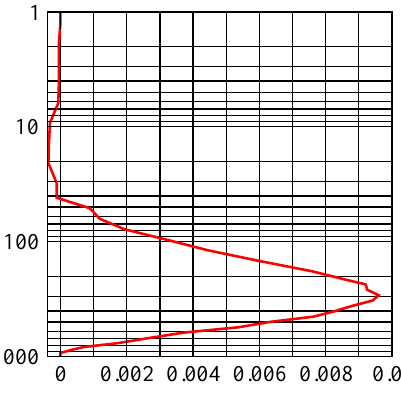
Fig. 12. Weighting function of CO2 column satellite as determined by Ch´edin et al. (2003).